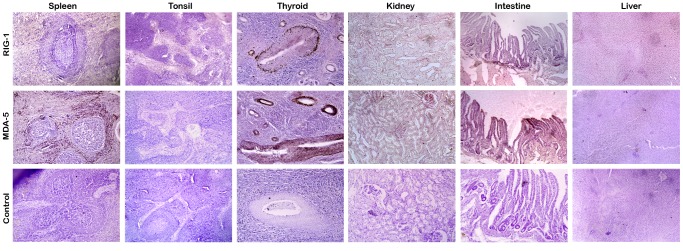
Constitutive protein expression levels of buffalo RIG1 and MDA5 in different tissues.Imuunohistochemical localization of RIG1 and MDA5 were detected in thin tissue sections using specific antibodies with DAB (3,3′-Diaminobenzidine) as substrate. Counterstaining was performed with Mayer’s haematoxylin.